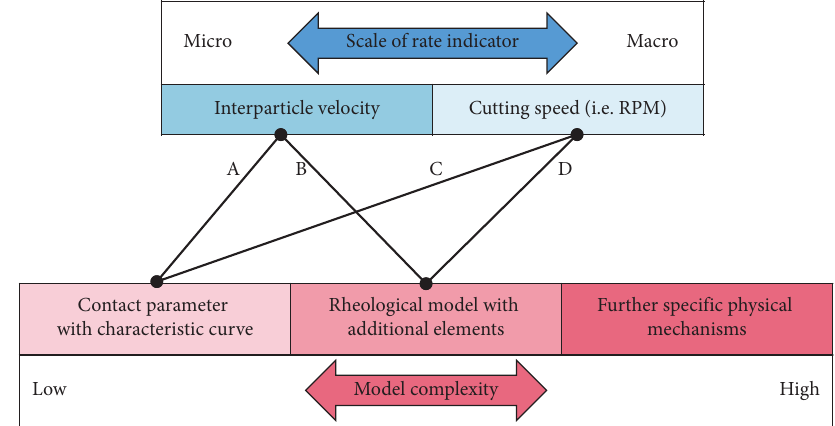
Figure 7: Modifcation strategies with respect to the rate dependency.